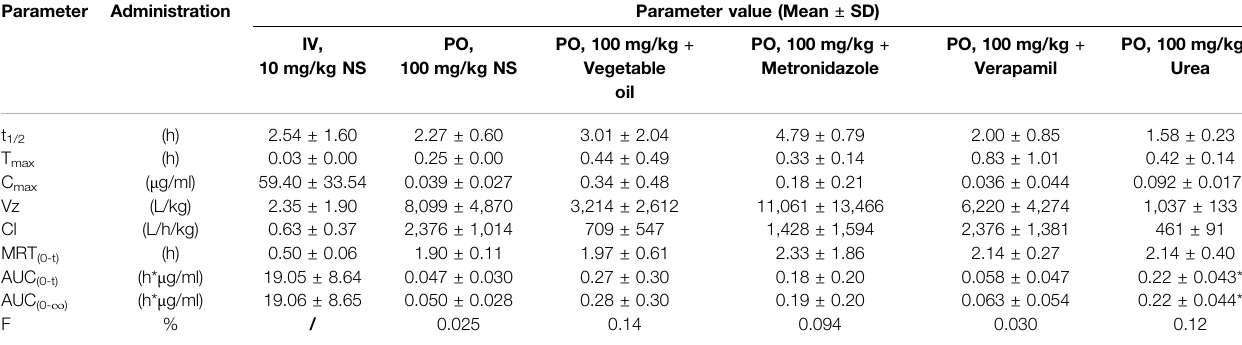
TABLE 3 | Pharmacokinetic parameters and bioavailability of ASD in rats after intravenous and intragastrical administration ( n (cid:2) 5). Parameter Administration